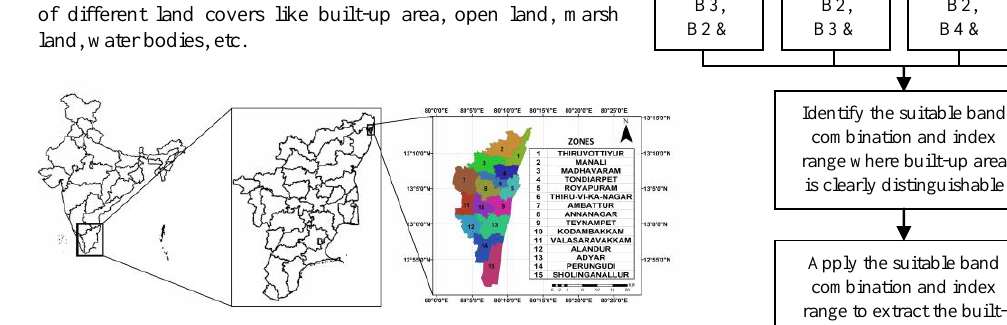
Figure 1. Map showing the location of Tamil Nadu state in India (left), location of Chennai Corporation in Tamil Nadu (middle) and Chennai Corporation (right).